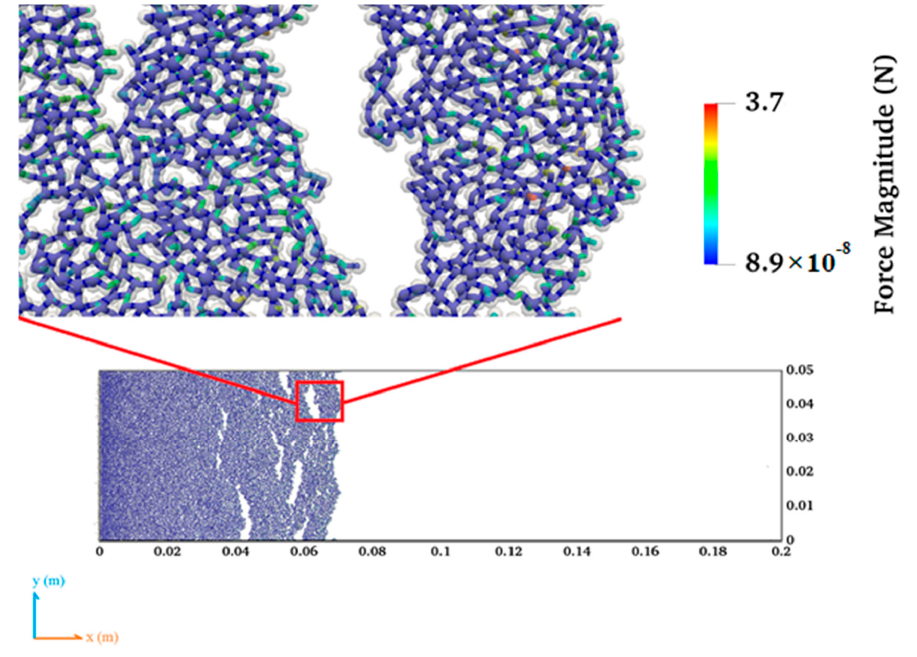
Figure 2. Fracture bridging and sealing by lost-circulation material (LCM) particles.